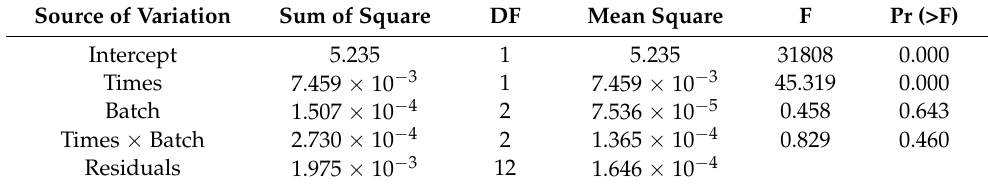
Table 5. ANCOVA type III sum of